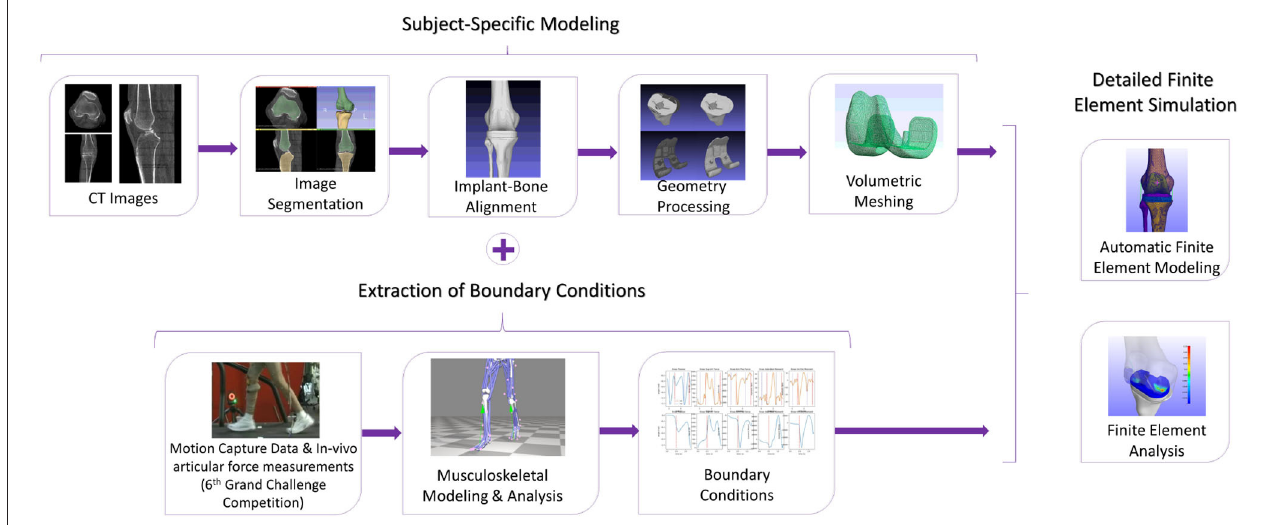
FIGURE 1 | The methodology to develop a subject-specific total knee replacement finite element (TKR FE) model. The subject-specific modeling includes the segmentation and aligning processes as well as geometry processing and volumetric meshing. The TKR model will have boundary conditions extracted from the 6th GCC, and it will be used for finite element analysis